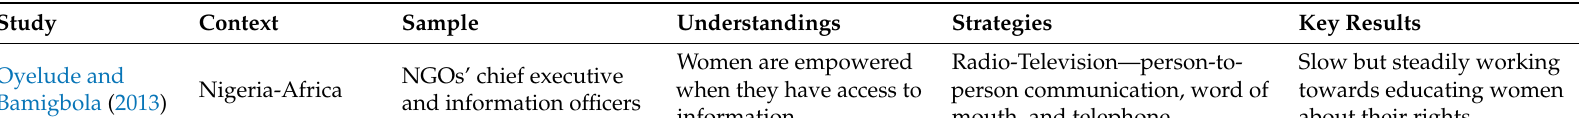
Table 2. Results of research studies on women’s